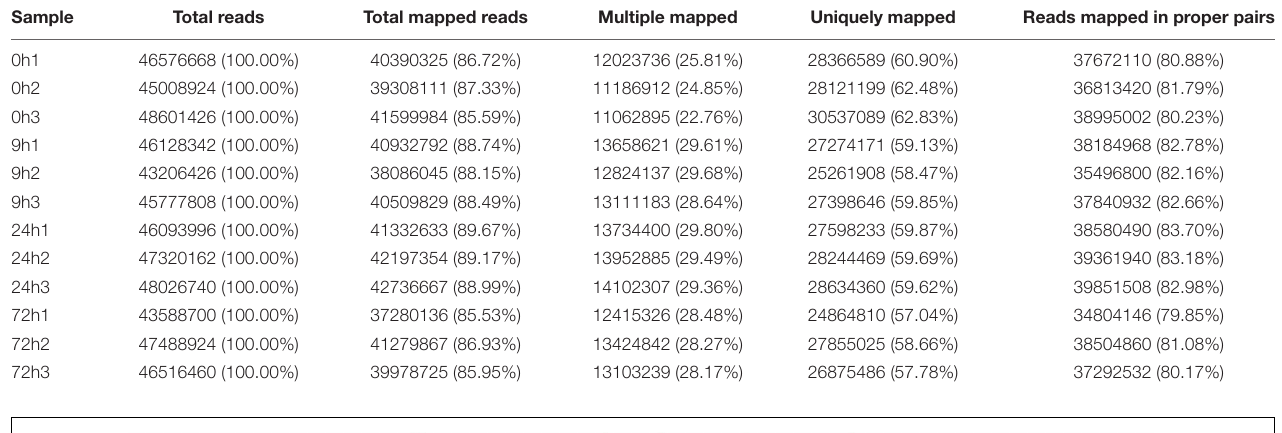
TABLE 4 | Mapping statistics of each sample.